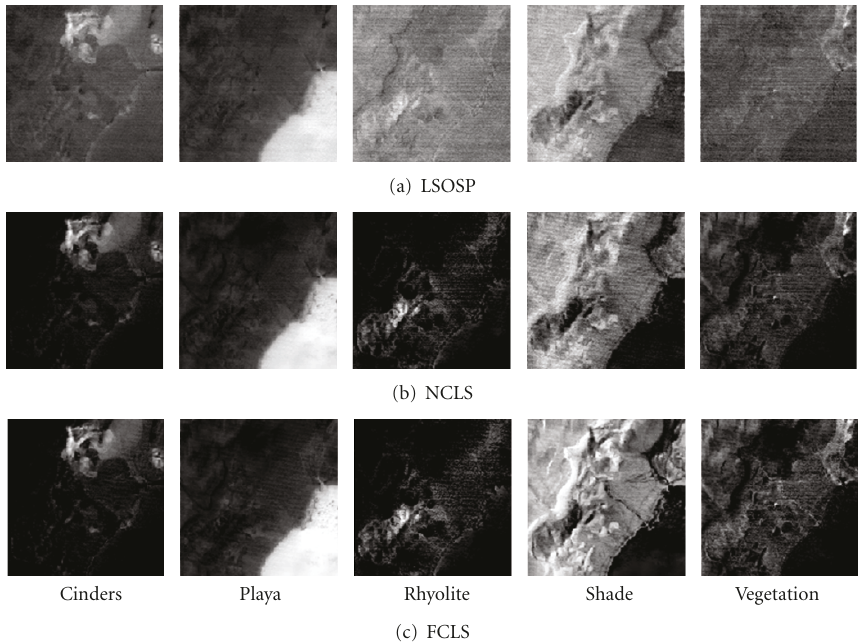
Figure 35: Unmixed results by unsupervised LSU, supervised LSOSP, NCLS, and FCLS using the five signatures in Figure